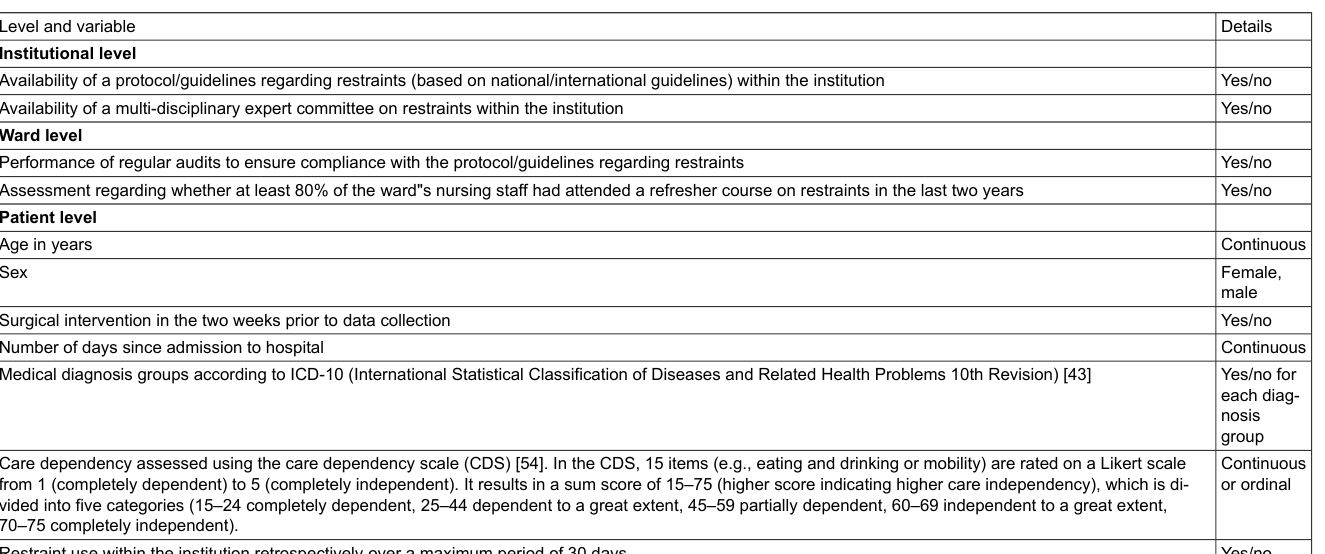
Table S1: Variables.